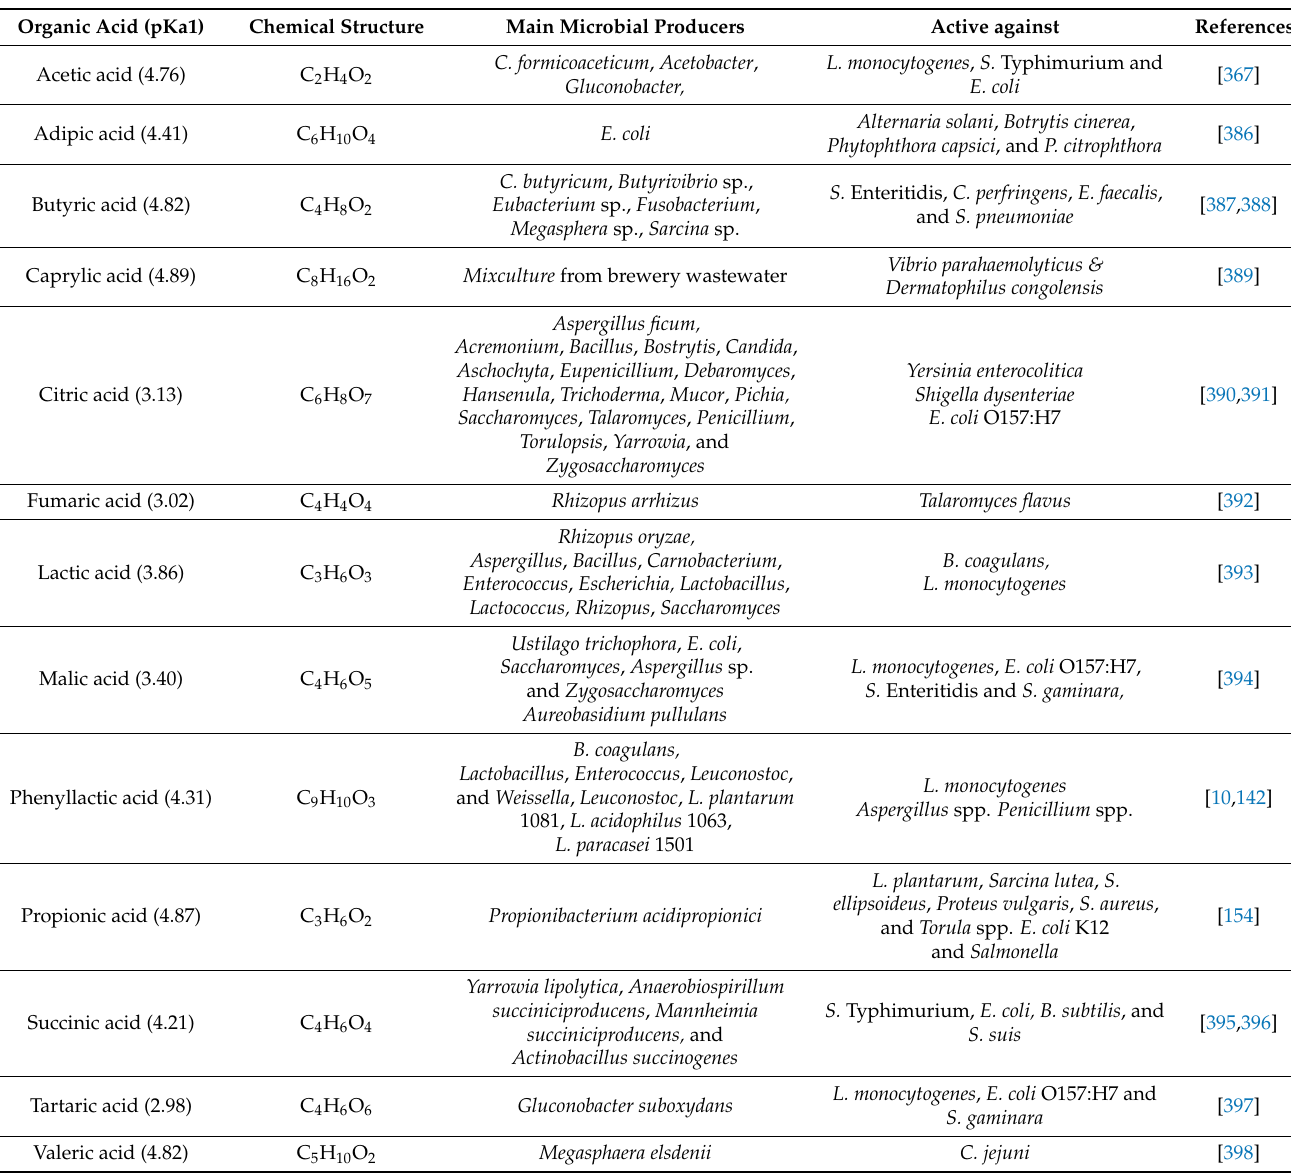
Table 6. The structures of commonly used organic acids, their main producers, and their activity against various pathogenic